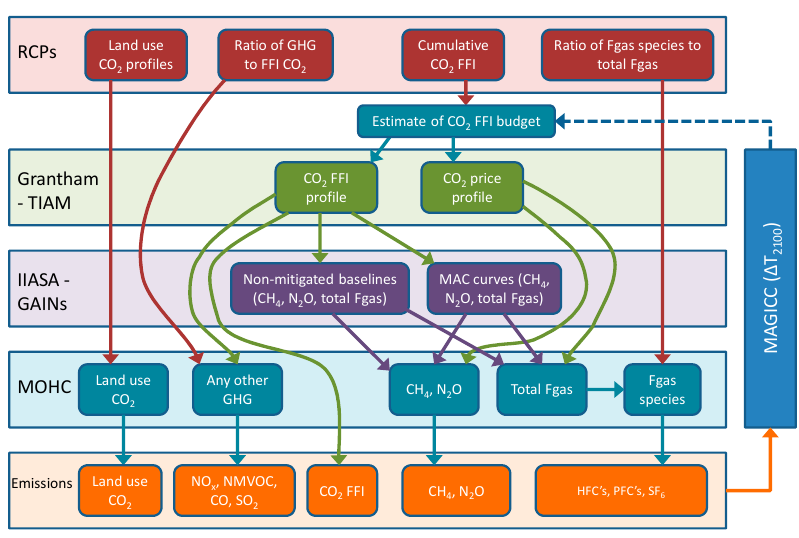
Figure A1. Schematic illustrating the process used to derive emissions scenarios from CO 2 budgets and iterate for target temperature levels where appropriate. RCP: Representative Concentration Pathway; GHG: greenhouse gas; FFI: fossil fuels and industry; MAC: marginal abatement cost; MOHC: Met Office Hadley Centre; NMVOC: non-methane volatile organic compounds; and MAGICC: Model for Greenhouse gas Induced Climate Change.